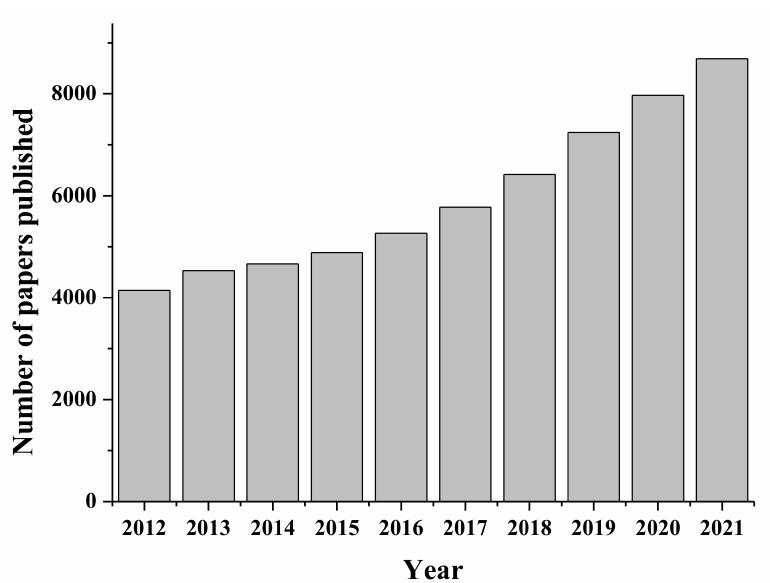
Figure 1. Number of papers published per year in the last decade with the keyword “starch”. Data extracted from the Web of Science database on 3 June